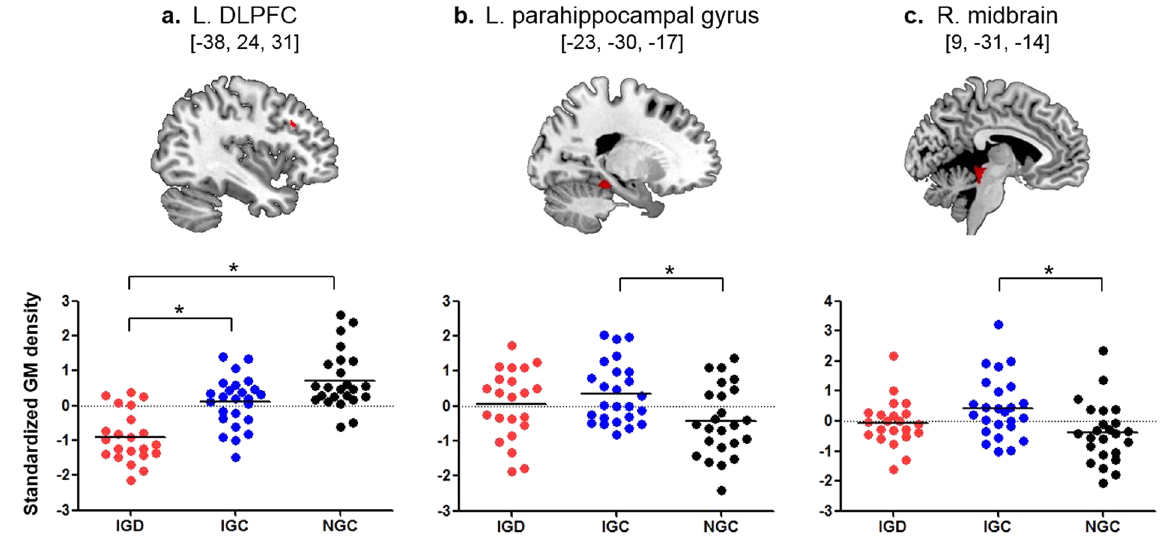
Figure 1. Voxel-wise comparisons among the Internet gaming disorder (IGD), Internet gaming control (IGC), and non-gaming control (NGC) groups. Standardized gray matter (GM) density was calculated for visualization. An analysis of covariance (ANCOVA) test detected the difference in ( a ) the left dorsolateral prefrontal cortex (DLPFC) among the three groups, and subsequent post hoc t-tests revealed the significant reduction in the IGD group compared with that in the IGC and NGC groups. The IGC group showed a higher GM density in a cluster covering ( b ) the parahippocampal gyrus and ( c ) midbrain than the NGC group. The results were adjusted for age and intelligence quotient (IQ). * Significant at P < 0.05.